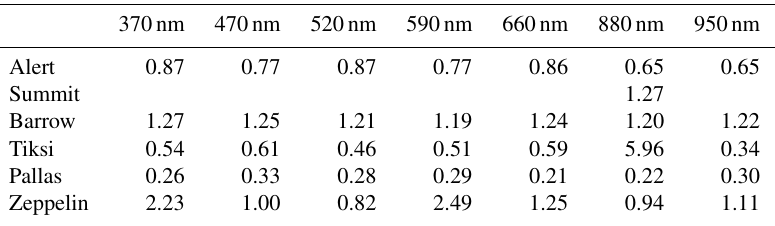
Table 4. Crossover (cid:49) ATN above which the flow rate uncertainty ( f q = 1.5%) and spot size uncertainty ( f a = 2.0%) together become more important than δ(cid:49) ATN ND